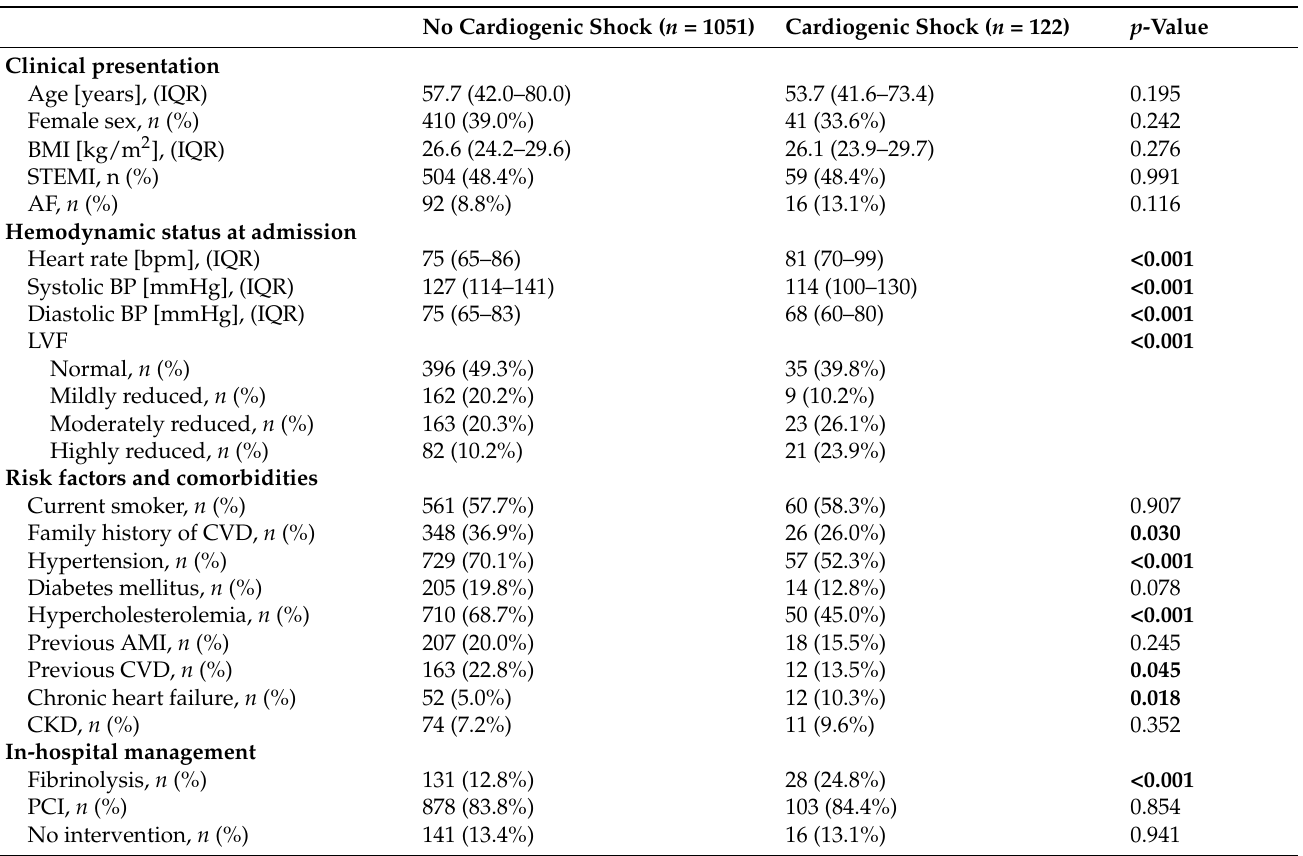
Table 1. Baseline